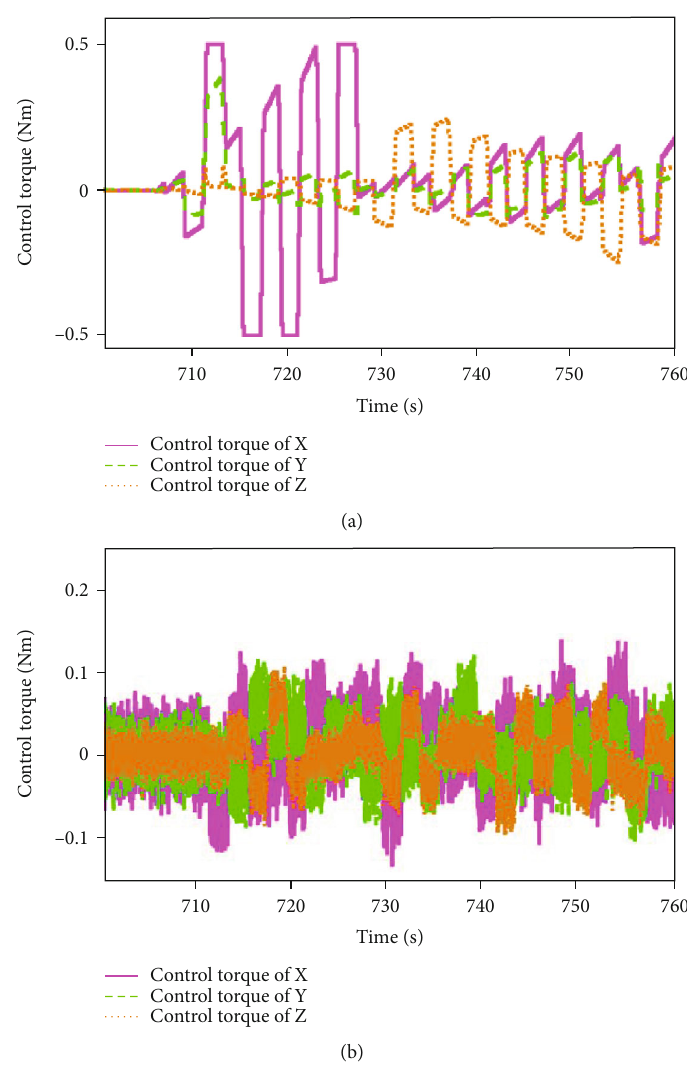
Figure 9: Control torque. (a) PD control. (b) Neural network sliding mode